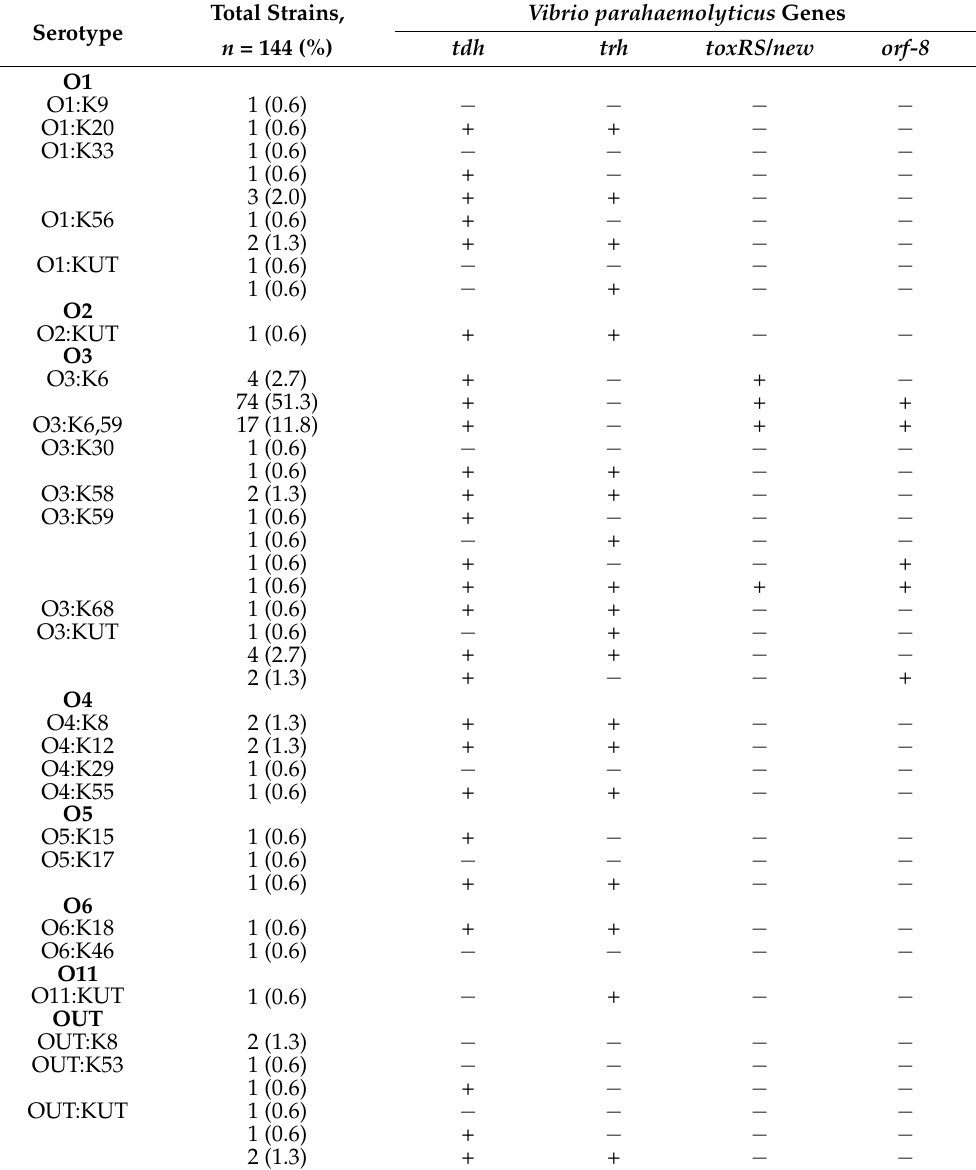
Table 2. Serotypes and virulence-related genes of Vibrio parahaemolyticus isolated from diarrhea cases in Mexico from 2004 to 2011.